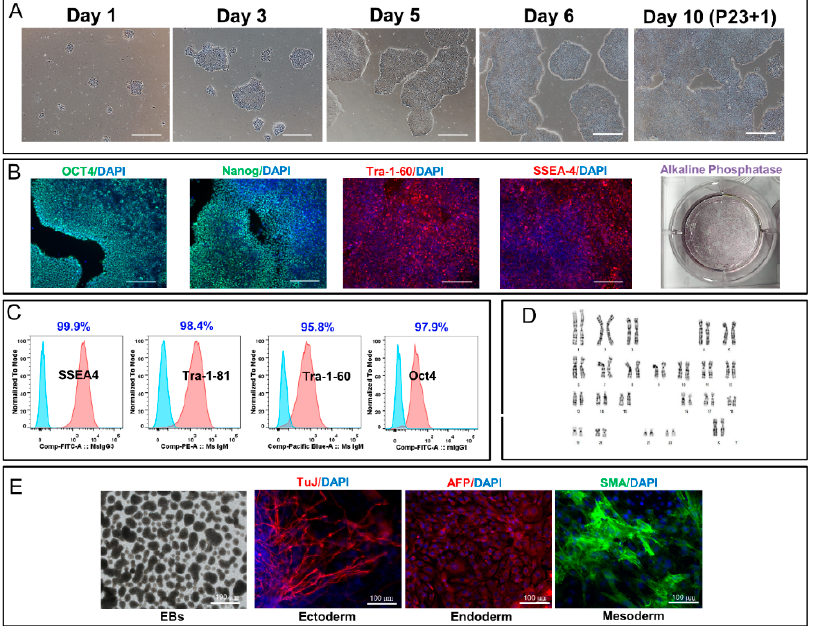
Figure 1. Thaw, expansion, and characterization of human LiPSC-18R post prolonged cryopreservation. ( A ) The induced pluripotent stem cells (iPSCs) attached and formed typical PSC colonies one day post thaw. The cells were passaged on day 6 and formed colonies one passage post thaw. Scale bars, 100 µm. ( B ) iPSCs stained positively with OCT4, TRA-1-60, SSEA4, NANOG, and AP. Scale bars, 100 µm. ( C ) iPSCs expressing the pluripotent stem cell internal and surface markers OCT4, SSEA4, TRA-1-60, and TRA-1-81 (dark pink). Light blue indicates the isotype control. ( D ) The iPSCs demonstrated a normal karyotype one passage post thaw. ( E ) iPSCs differentiated into embryoid bodies and readily expressing the markers for early ectoderm (TUJ1, beta-tubulin), endoderm (AFP, alpha feto protein), and mesoderm (SMA, smooth muscle actin). Scale bars, 100 µm.